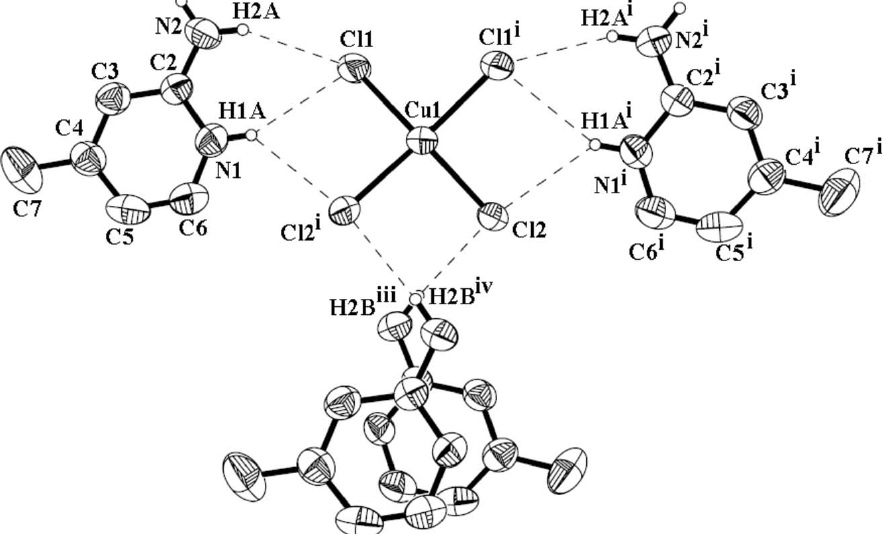
The structure of the title compound, viewed down c . Displacement ellipsoids are drawn at the 50% probability level. N— H···Cl—Cu intermolecular interactions are shown as dashed lines. Symmetry operations: (i) - x + 1, y , - z + 3/2; (iii) -1/2 + x , 1/2 + y , z ; (iv) 3/2 - x , 1/2 + y , 3/2 - z . H atoms not involved in hydrogen bonding omitted for